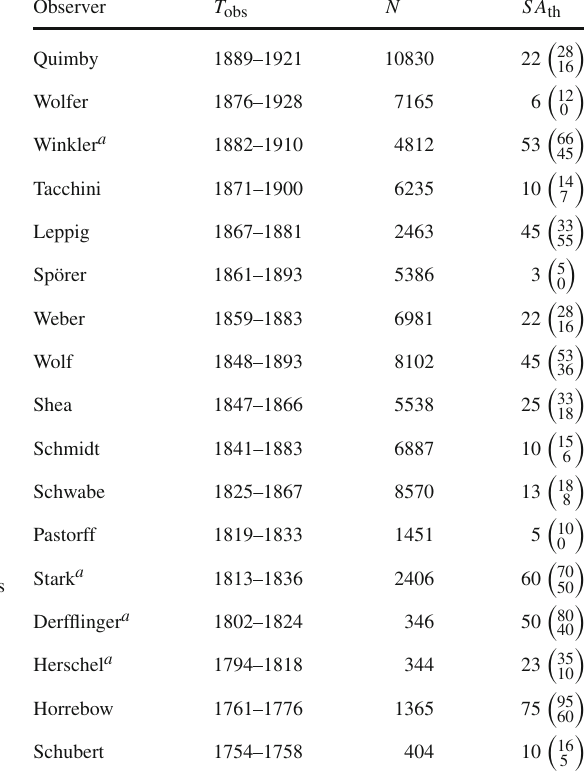
Table 1 Values of the observational acuity threshold for the key observers of the 18–19th centuries